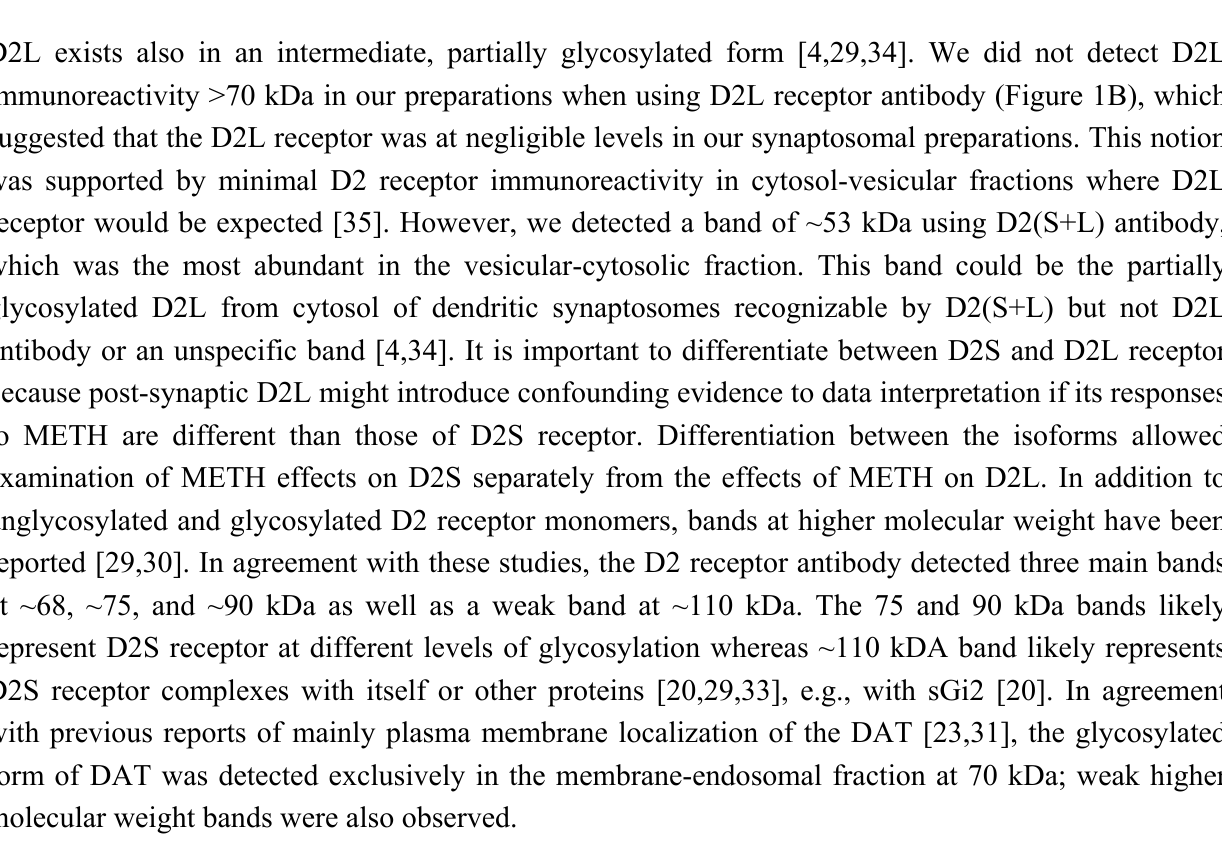
Figure 1. Dopamine D2 receptor and dopamine transporter (DAT) species in rat striatal synaptosomes. ( A ) The immunoreactivity of the antibody recognizing both D2S and D2L isoforms of D2 receptor; ( B ) the immunoreactivity of the antibody recognizing the D2L receptor; and ( C ) the immunoreactivity of the antibody recognizing the